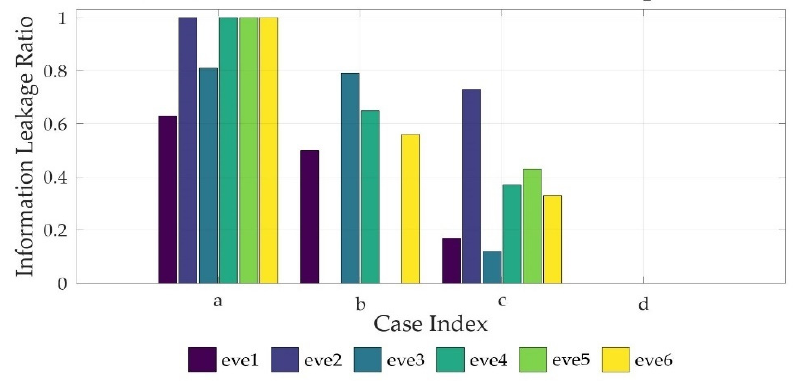
Figure 7. Field experiment results; conventional schemes ( a – c ) and proposed scheme ( d ).